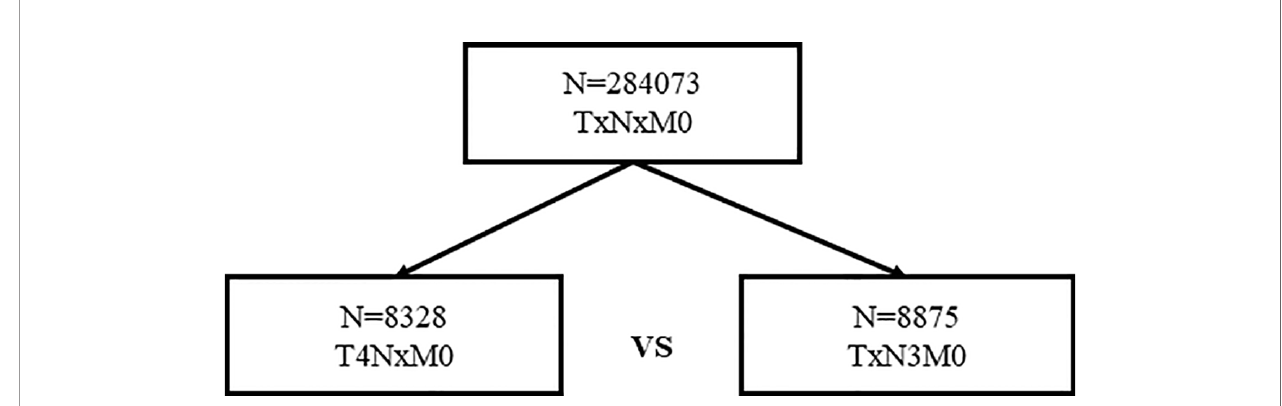
FIGURE 3 | Patient selection for survival comparison of T4 and N3 tumors.